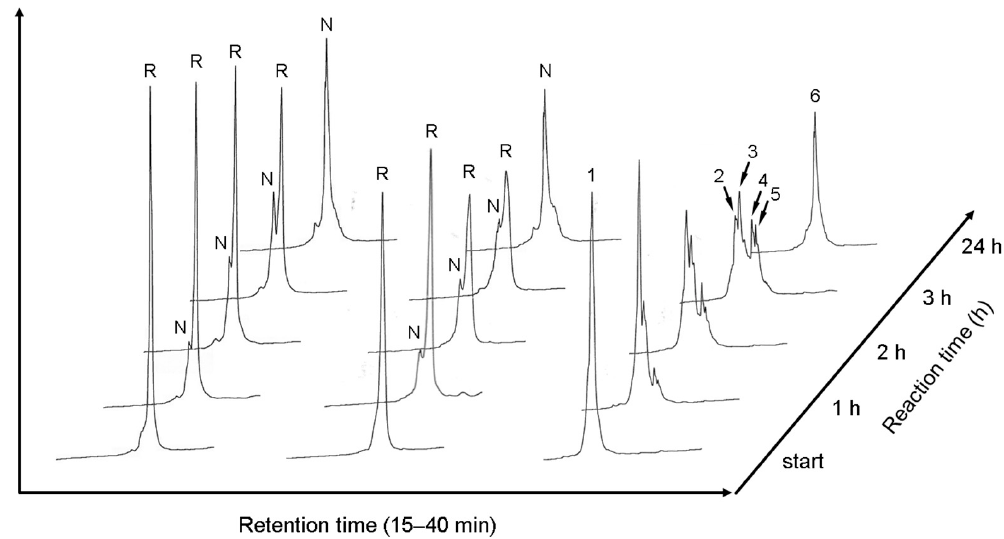
Figure 4. RP-HPLC profiles of refolding mixtures of the [K8D]-proCCN (cid:48) protein. Reaction mixtures without treatments are shown in the left lane. The refolding mixtures were treated with N -ethylmaleimide (middle) or the Male-Arg 5 -Tyr-NH 2 reagent (right) at each time point. “R” and “N” represent the fully reduced and native forms of the [K8D]-proCCN (cid:48) protein. RP-HPLC analyses were performed using a TSKgel Protein C 4 -300 column and the acetonitrile concentration was increased from 27.5% to 40% for 25 min. Peaks 1–5 (right column) were determined by mass spectrometric analyses, as summarized in Table